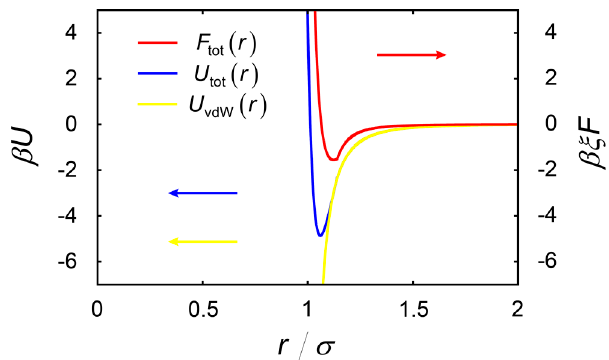
Figure 6. The interparticle potential ( blue line ) and the force ( red line ) acting on cells. There exists a soft repulsive force close to the cell wall. The yellow line is plotted according to Equation (4), and this potential could effectively describe the medium-ranged nature of the attractive potential.